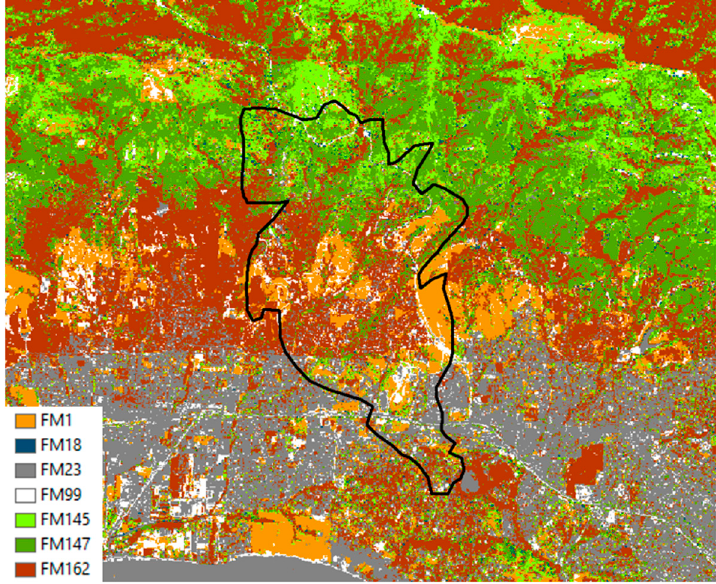
Figure 6. New fuel map for the Painted Cave fire, incorporating FM145 and FM147.